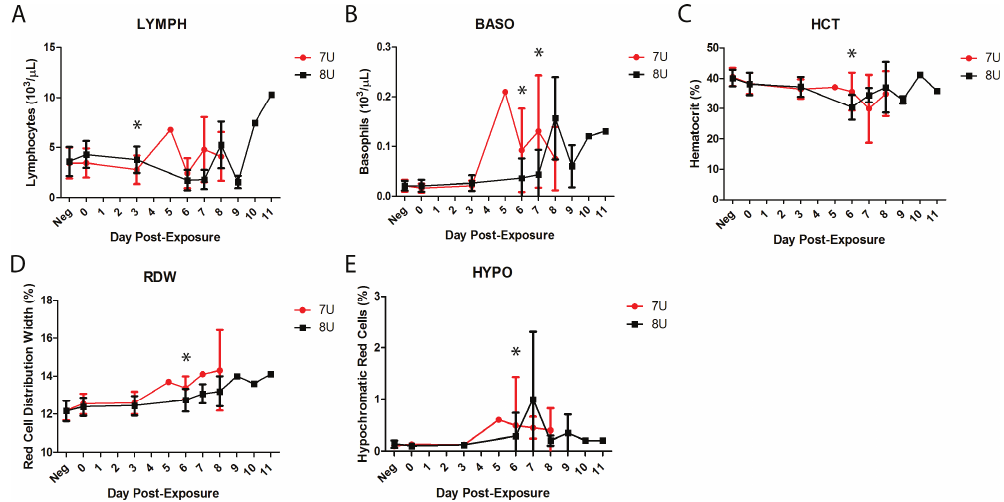
Figure 5. Average hematology values in naïve challenge groups . All error bars represent standard deviation. Asterisks indicate statistically significant differences between the two groups (7U, n = 14, red ; 8U, n = 14, black ). ( A ) Average concentration of lymphocytes in whole blood for naïve NHPs shown in 1000 cell per µL; ( B ) Average basophils in whole blood for naïve NHPs shown in 1000 cells per µL; ( C ) Average hematocrit of naïve NHPs by percent; ( D ) Average red cell distribution width for unvaccinated control NHPs shown as percent; ( E ) Average percent hypochromatic red cells in naïve NHP whole blood.